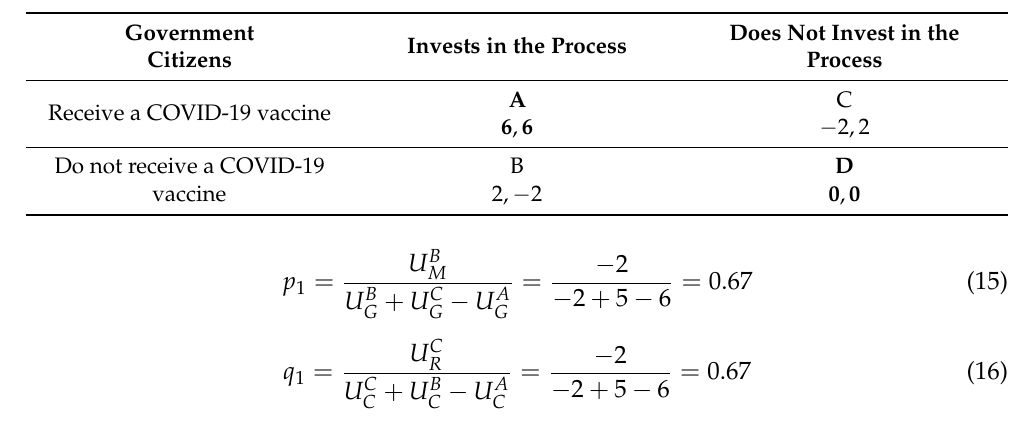
Table 5. Game matrices for the